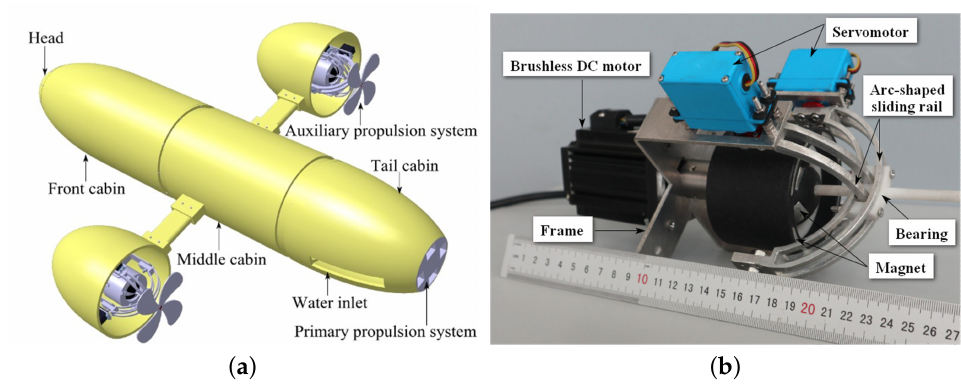
Figure 25. New underwater robot based on an S-RMCT [115]. ( a ) New UR based on S-RMCT. ( b ) Only the